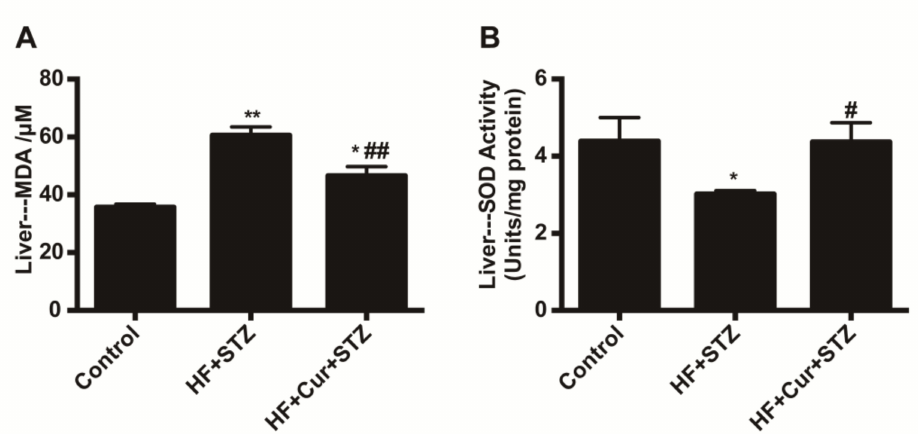
Figure 6. The e ff ects of curcumin intervention on oxidative stress in rats fed a high-fat diet then treated with streptozotocin. ( A ) The e ff ect of curcumin intervention on malondialdehyde (MDA) content in the liver. ( B ) The e ff ect of curcumin intervention on superoxide dismutase (SOD) content in the liver. The data are expressed as the mean ± SEM. * p < 0.05, ** p < 0.01, compared with the control group; # p < 0.05, ## p < 0.01 compared with the HF + STZ group. Control ( n = 6), HF + STZ ( n = 10), and HF + Cur + STZ ( n =